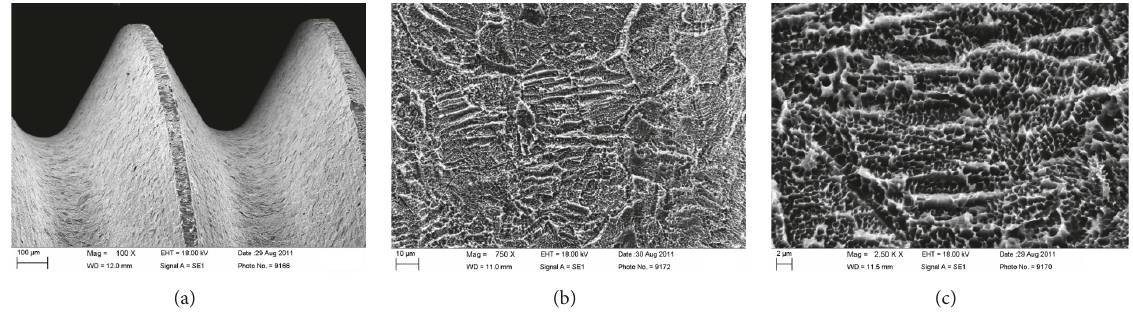
Figure 3: Scanning electron microscopy (SEM) evaluation of the dual acid etched (DAE) implant surface. The surface (a) presented micron- sized shallow cavities uniformly covered by submicroscopic pitting (b) limited by razor-sharp cusps and edges (c).